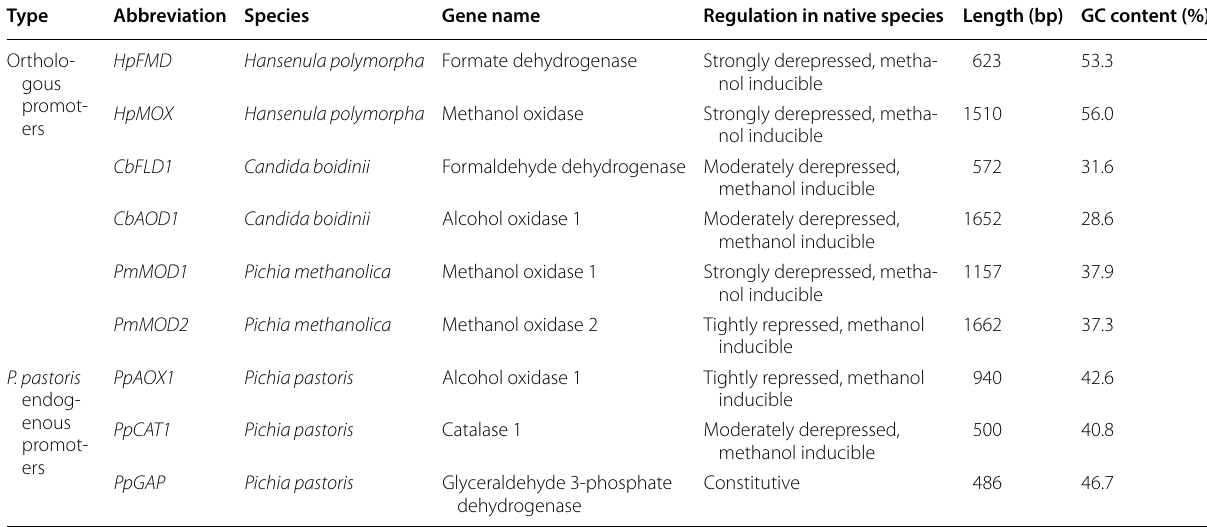
Moderately derepressed: < 50% of methanol induced levels; strongly derepressed: > 50% of methanol induced levels [according to the data by (Hartner and Glieder 2006)]. Promoter lengths used in this study are listed and deviate in part slightly form values reported in the literature (see “Materials and methods” section